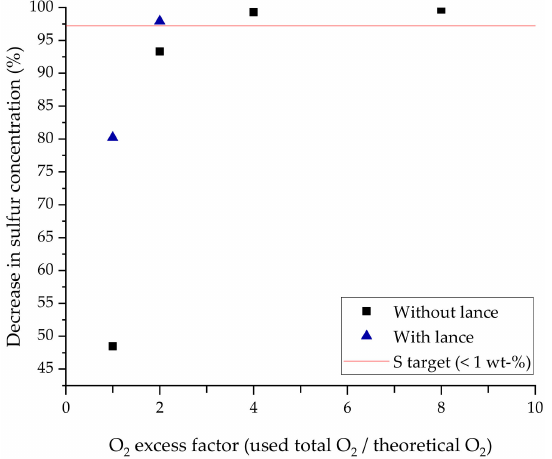
Figure 2. The effect of O 2 excess factor on the reached decrease in sulfur concentration of a sample. O 2 excess factor describes how many times the theoretically needed amount of oxygen was used. The target for achieving S < 1 wt % is at